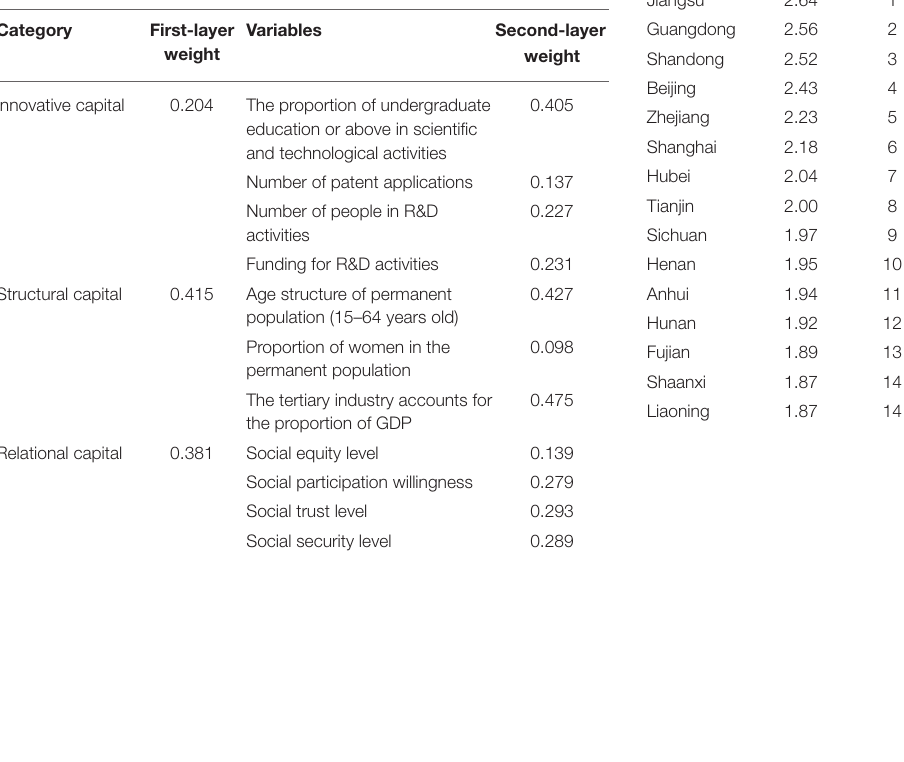
Table A1 | The weight of the social capital indicator system.